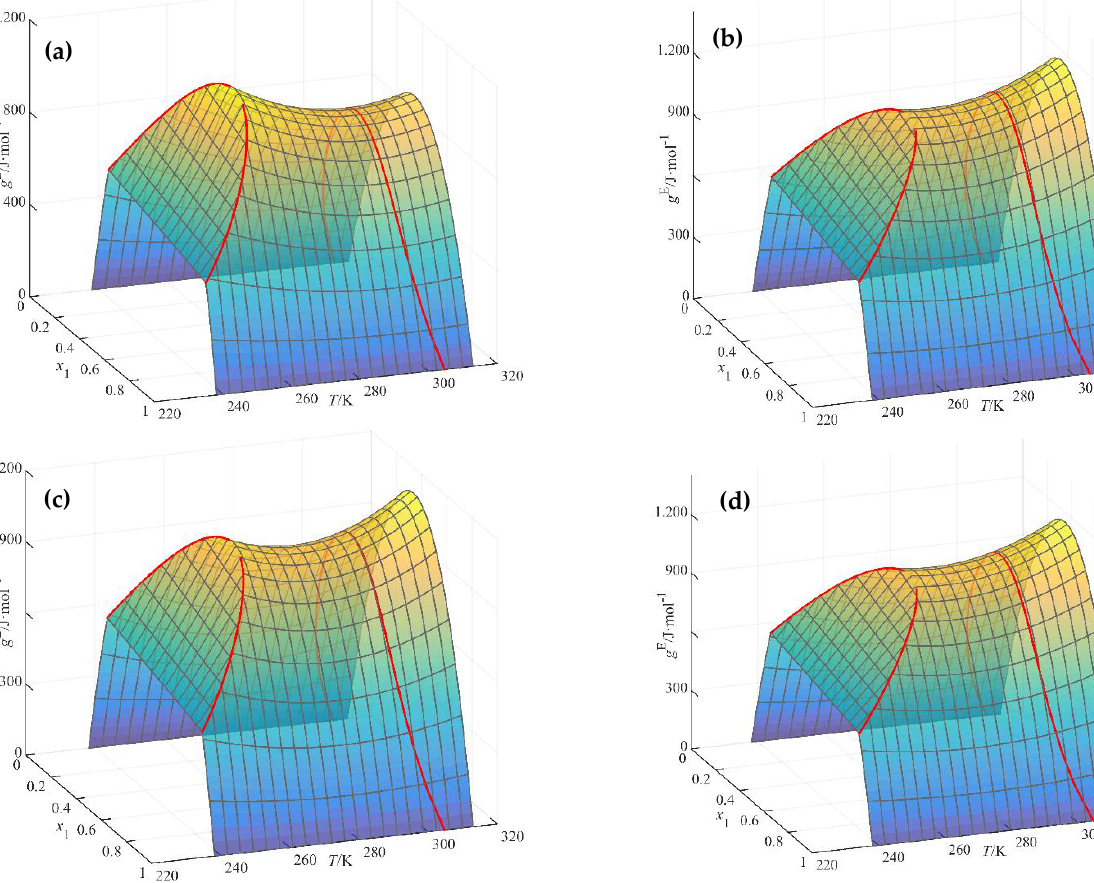
Figure 11. Plot of g E vs x 1 , or T using NRTL with the parametrizations of Table 3. ( a ) P1; ( b ) P2; ( c ) P3; ( d ) P4. ( — ). Geometric space of g E for the two phases VLE and LLE.